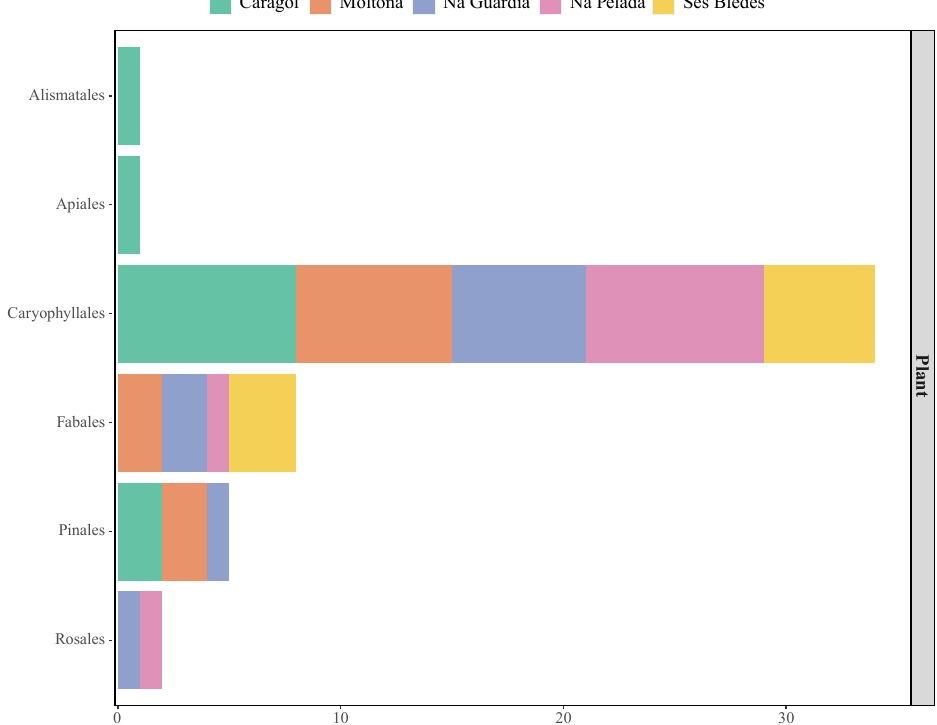
Figure A1. Frequencies of occurrence of each order of plants in the diet composition of Podarcis lilfordi through molecular analysis.